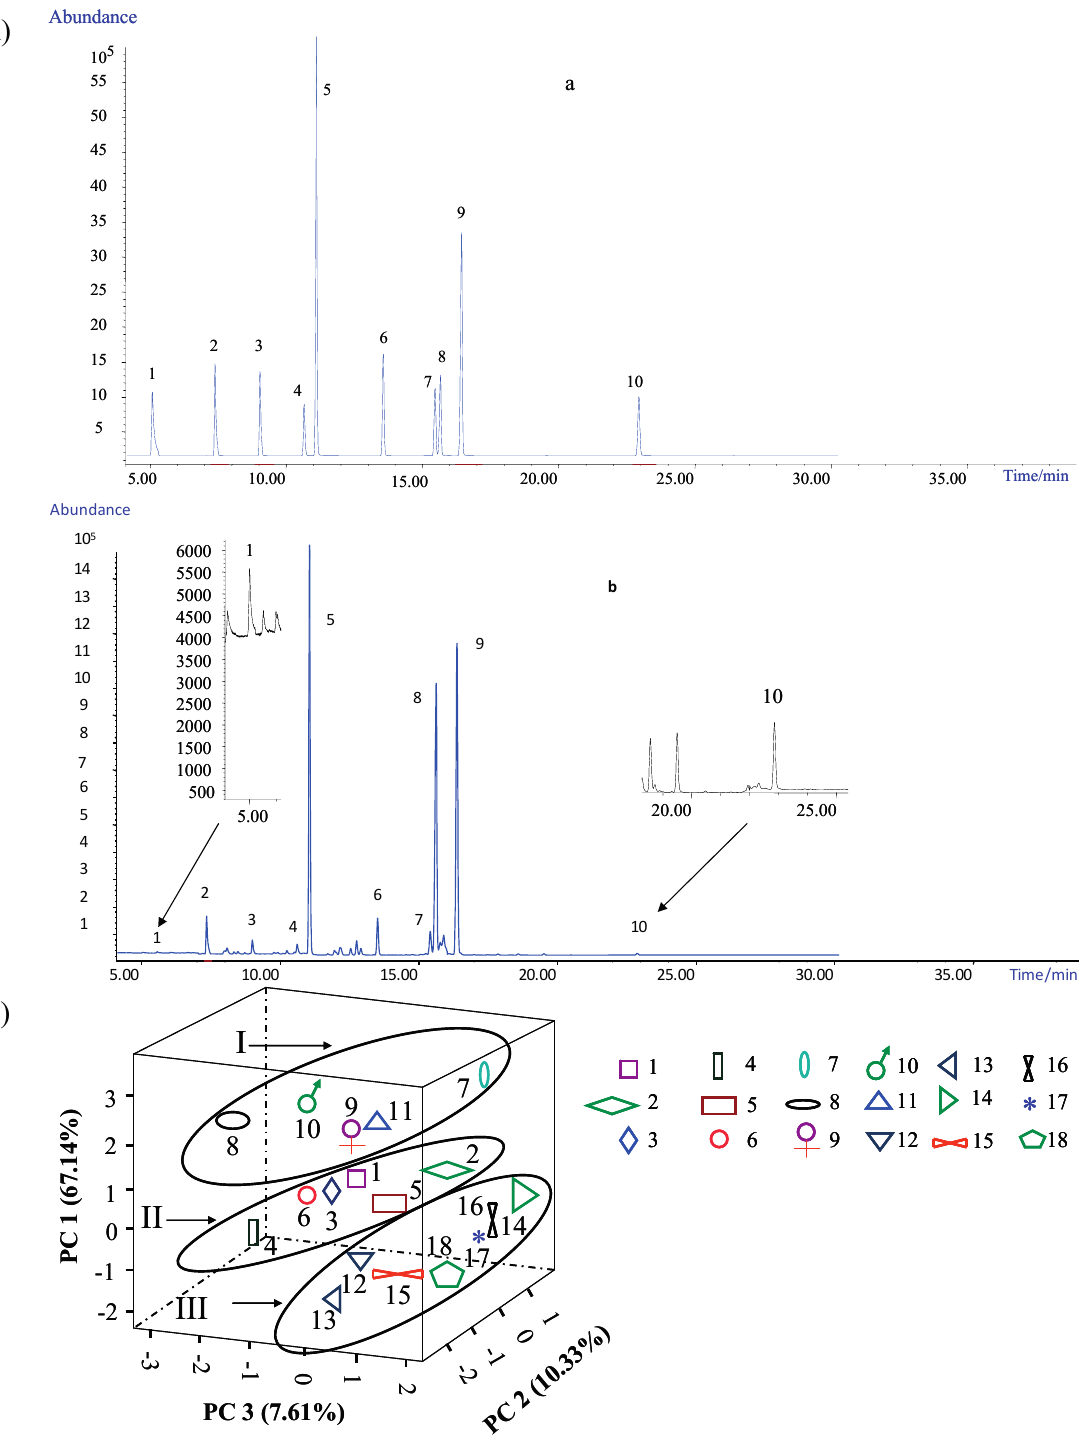
Figure 2. GC–EI-qMS chromatograms of the ten FAMEs standard mixture and sample under SIM mode and principal component analysis (PCA) of 18 SO samples. ( A ) ( a ) mixed standard solution (the concentration of ( 1 – 10 ) was 10.8, 47.6, 31.6, 13.0, 11.2, 12.8, 10.0, 20.0, 20.0 and 20.0 μ g/mL, respectively), ( b ) SO sample solution. ( 1 ) DODME, ( 2 )